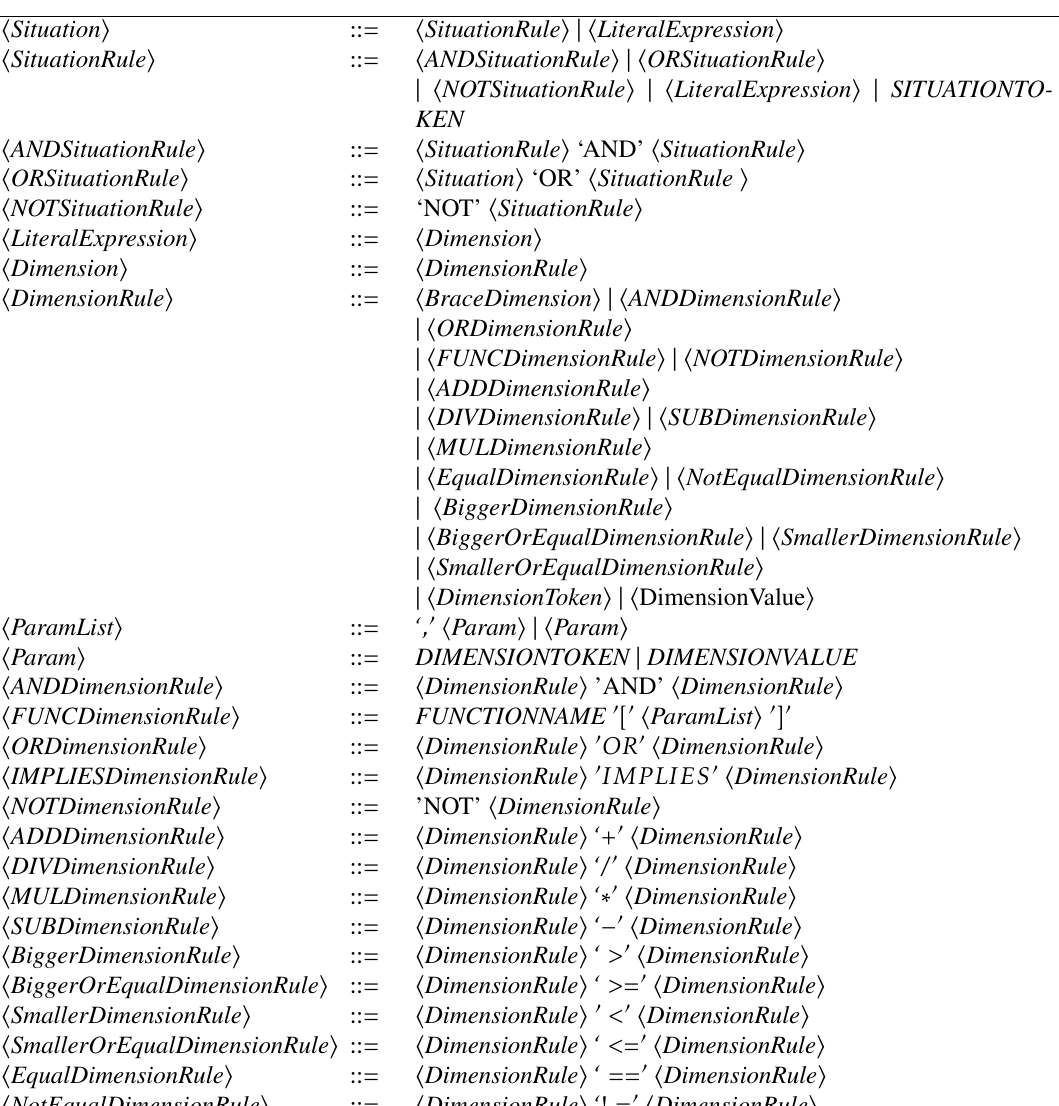
Table 11. Context Free Grammar for Situations in